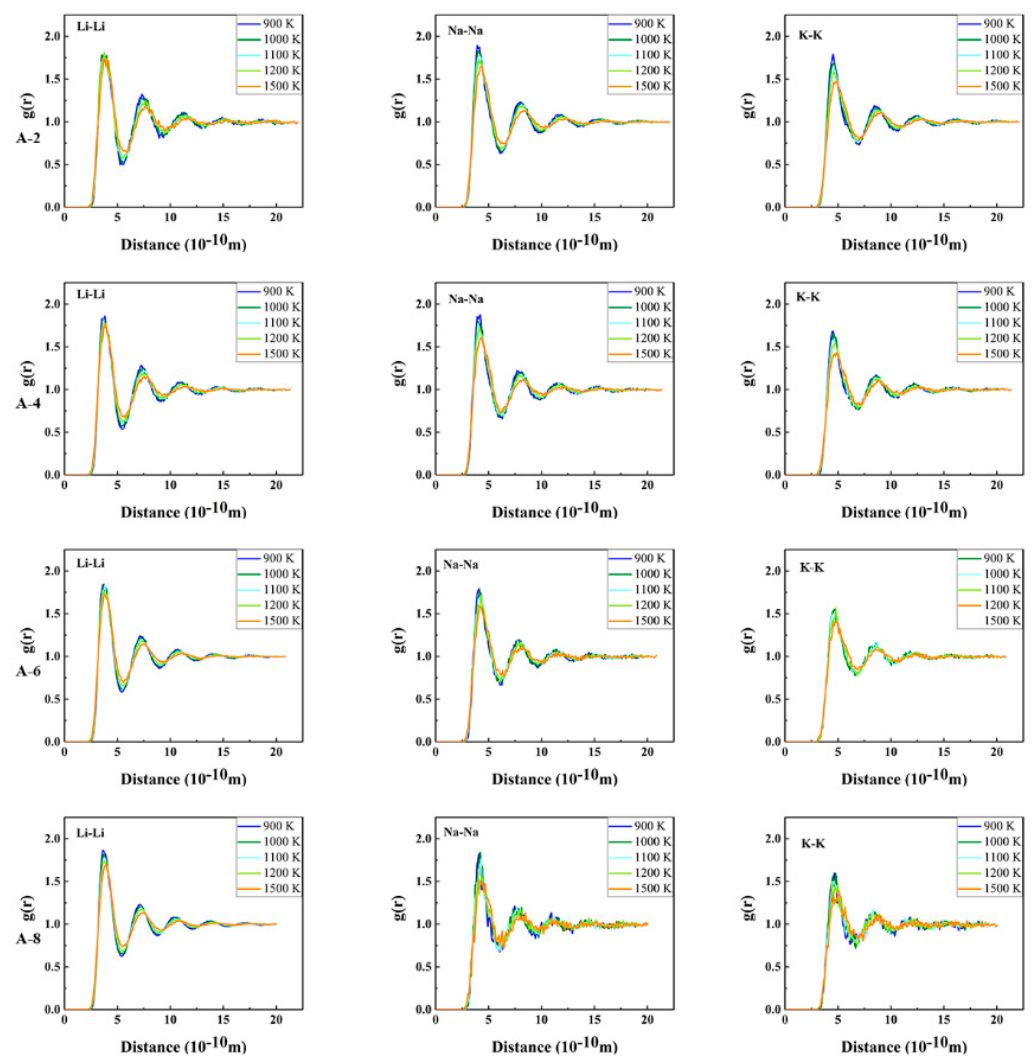
Figure A1. PDFs of like cation-cation pairs in the four ternary systems (A-2, A-4, A-6, and A-8) at 900 K, 1000 K, 1100 K, 1200 K, and 1500 K.